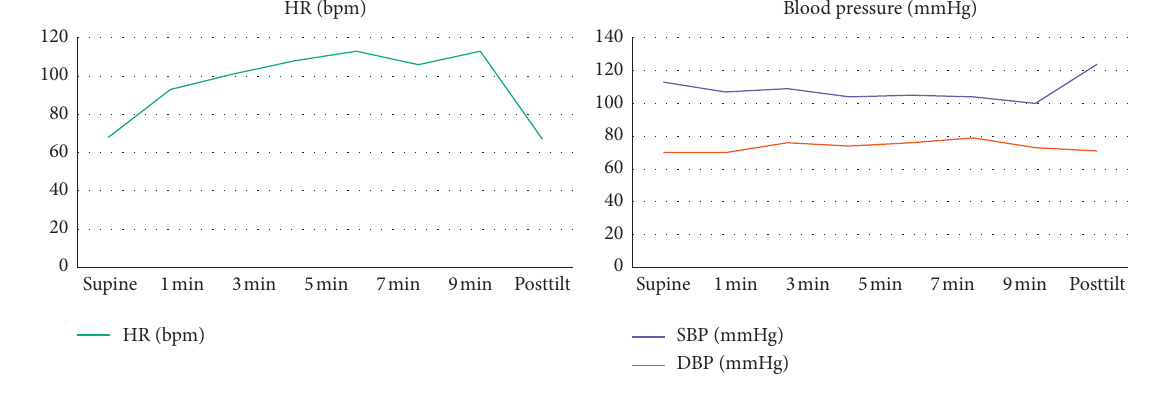
Figure 1: Results of tilt table test.